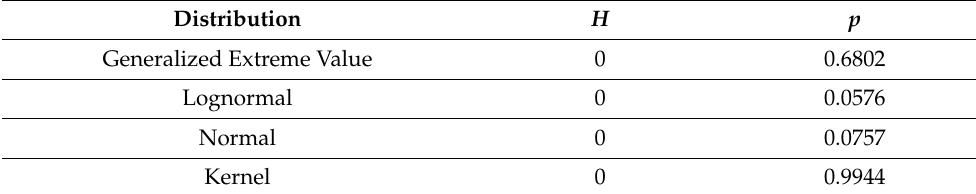
Figure 5. Results of distribution fitting using training data: ( a ) histogram; ( b ) probability density functions; ( c ) cumulative distribution function. Table 3. Results of K–S test for case one.